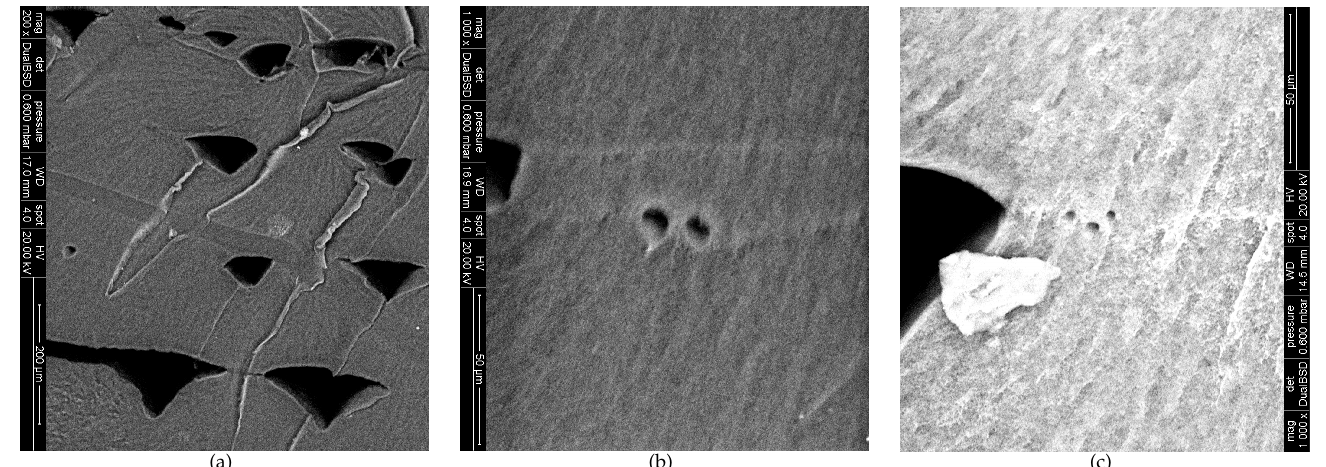
Figure 8. Detailed SEM micrographs of the ME-AM sample fracture cross-sections for 3 printing speeds. ( a ) v p = 5 mm/s; ( b ) v p = 20 mm/s; ( c ) v p = 35